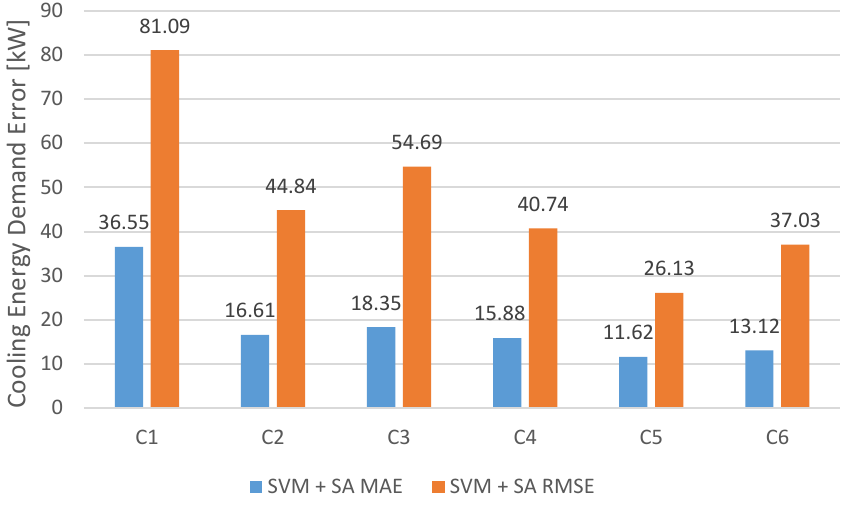
Figure 17. Error metrics for cooling energy demand using SVM+SA.